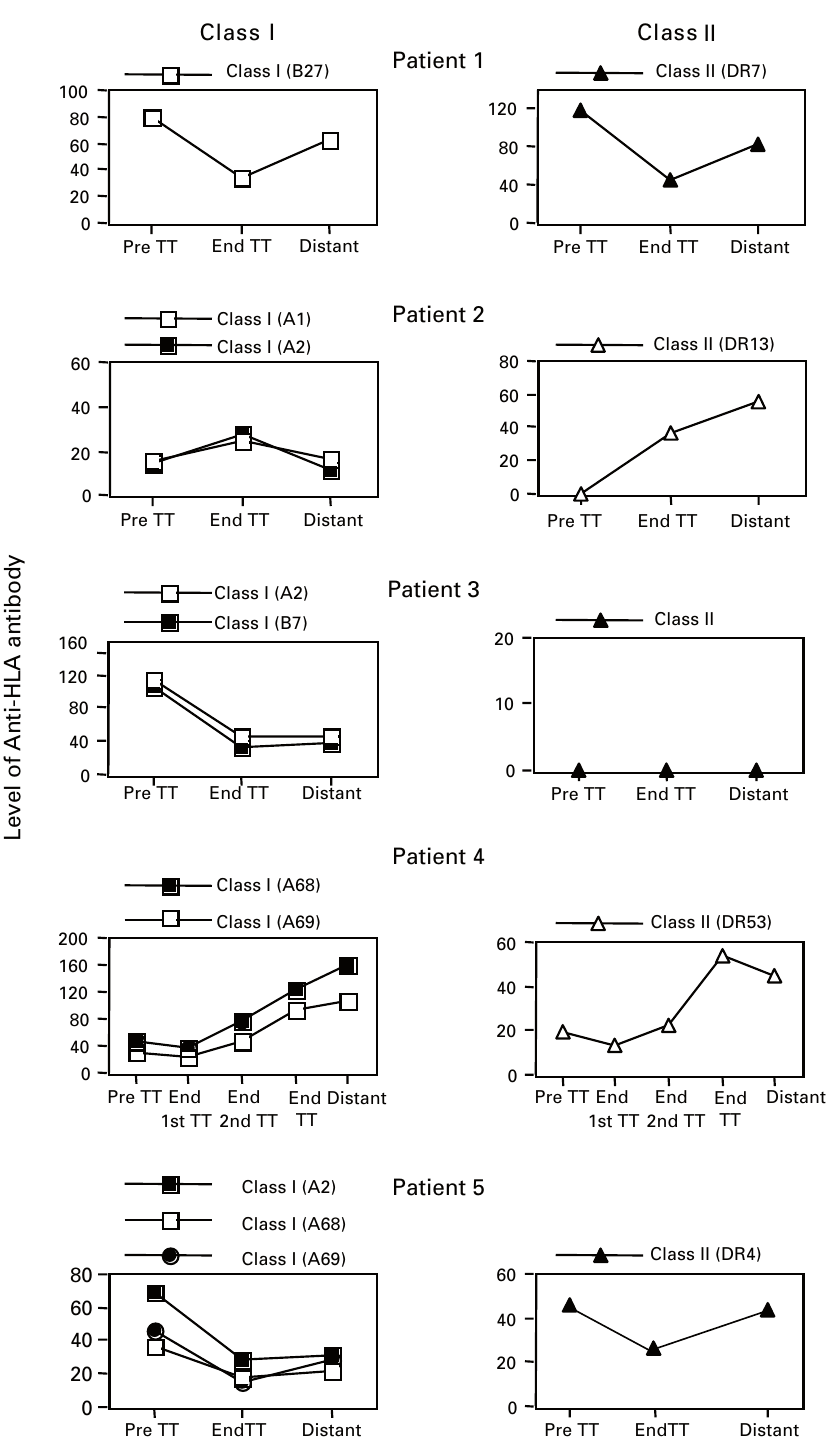
Changes in Donor Specific Antibodies (DSA) during the study determined by Luminex. A For each patient, we focused our analysis on anti-HLA antibodies developed against HLA anti- gens of a previous graft determined by LABScreen ® PRA Class I (left column) and LABScreen ® PRA Class II (right column). The anti-HLA antibodies detected were confirmed by LABScreen ® Single Antigen (data not shown). The levels of anti-HLA antibodies with intensities of 6 and 8 are calculated as the ratio between the mean fluorescence of each serum-HLA microbead and the mean fluorescence of the positive control (LABScreen ® PRA). Due to the high sensitivity of this test, only intensities of 6 and8 were taken into account. Anti-HLA antibodies were analysed before IVIg infusion at the end of the treatment (End TT) and 6 months after (distant). We also report the result of patient 4 after the first (End 1st TT) and second (End 2nd TT) IVIg infusion. B In control patients, we analysed anti-HLA antibodies developed against HLA antigens of a previ- ous graft over time (3 and 6 months). Anti-HLA antibodies developed against HLA antigens of a previous graft determined by LABScreen ® PRA Class I (left column) and LABScreen ® PRA Class II (right column). The anti-HLA antibodies detected were confirmed by LABScreen ® Single Antigen (data not shown). As control patient 8 had not received a prior graft, we analyzed the major anti- HLA antibodies detected. Due to the high sensitivity of this test, only intensities of 6 and 8 were taken into